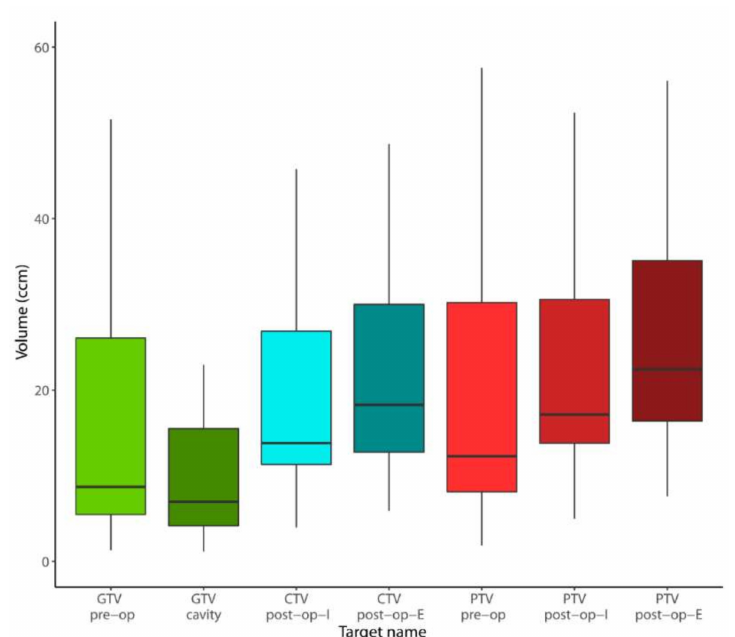
Figure 2. Boxplot illustrating target volume sizes in comparison. Abbreviations: GTV: gross target volume; CTV: clinical target volume; PTV: planning target volume; pre-op: pre-operative setting; post-op-I: post-operative involved field (cavity + 3 mm); and post-op-E: post-operative extended field (including surgical tract).